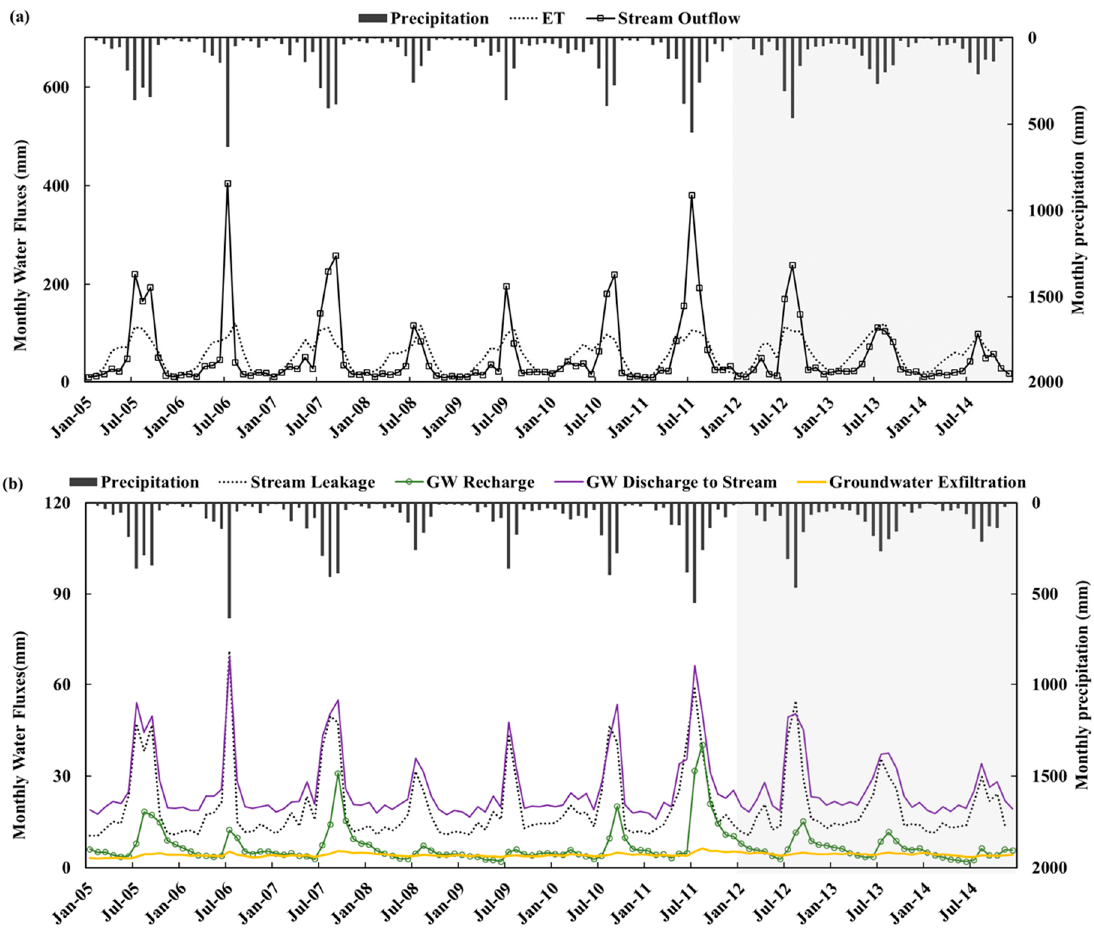
Figure 9. Monthly variability in different water balance components over the 10-year GSFLOW simulation period (2005–2014): ( a ) precipitation, evapotranspiration (ET) and streamflow; ( b ) precipitation, stream leakage, groundwater recharge, groundwater discharge to the streams and groundwater exfiltration.